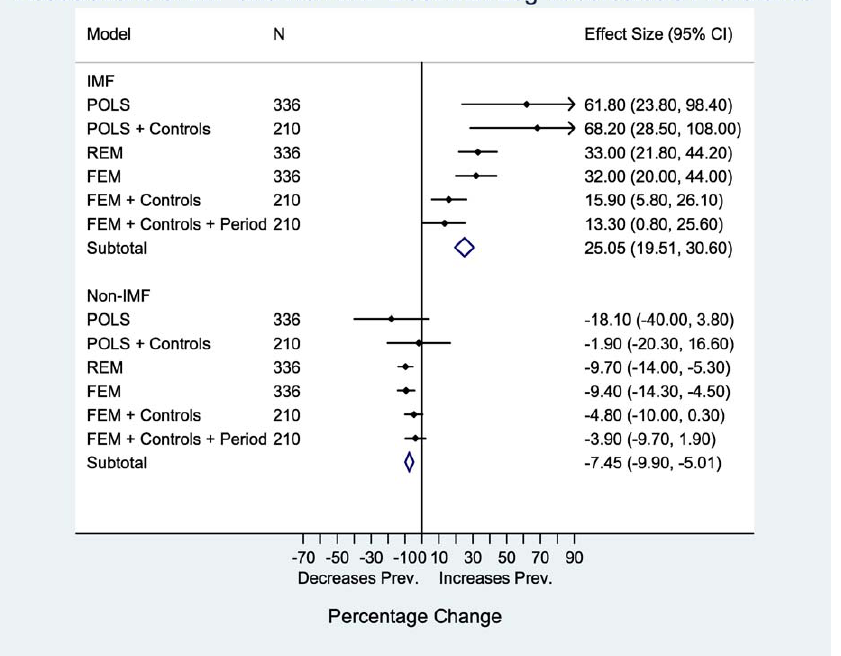
Figure 3. Forest Plot: Effects of IMF and Non-IMF Debt on Log Tuberculosis Prevalence Results based on six separate regression models using various controls and functional forms. Weighting used for aggregation calculated based on confidence intervals provided in STATA’s standard metan module. Controls include either IMF or non-IMF program, change in log GDP, level of log GDP per capita, democratization index, dummy for occurrence of military or ethnic conflict, population dependency ratios, percentage of the population with tertiary education, and urbanization rates. CI, 95% confidence interval; FEM, fixed effects model, which uses a set of country dummies; POLS, pooled OLS model; REM, random effects model. ‘‘ Period ’’ refers to a set of year dummies.